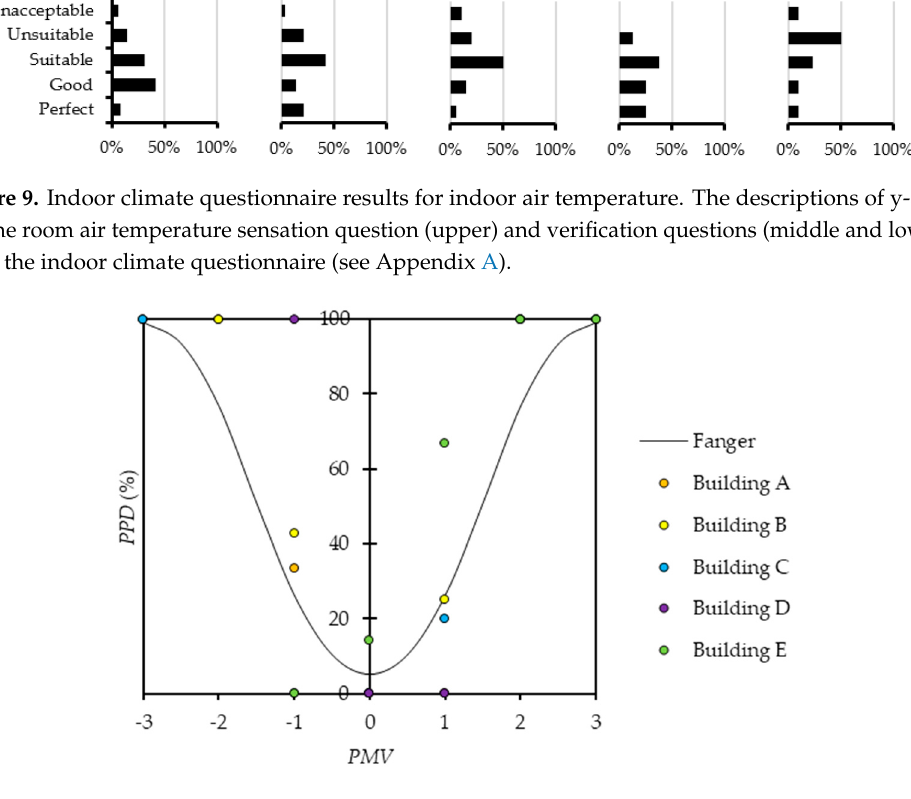
Figure 10. Indoor climate questionnaire results for predicted percentage of dissatisfied and predicted mean vote.